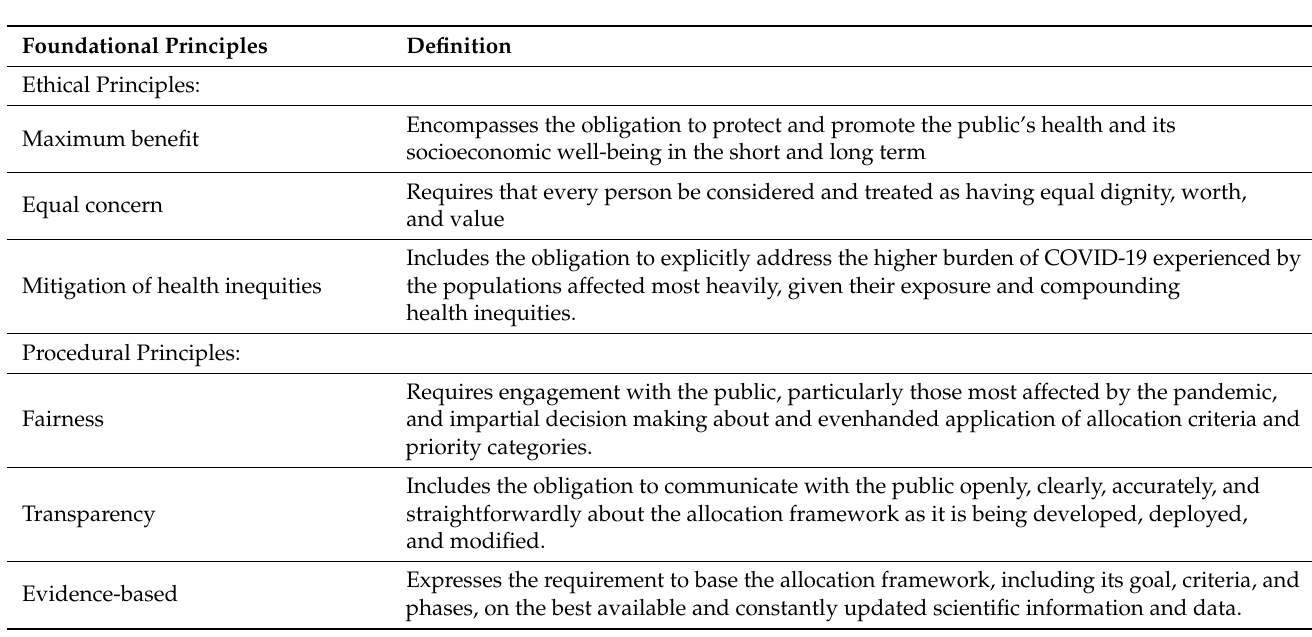
Table 1. Foundational principles of equitable allocation reprinted/adapted with permission from the National Academies of Sciences, Engineering, and Medicine (NASEM) [7]. Copyright 2020, National Academy of Sciences. The Vaccine Allocation Strategy Branch (VASB) utilized these principles for the NH COVID-19 vaccine allocation framework.